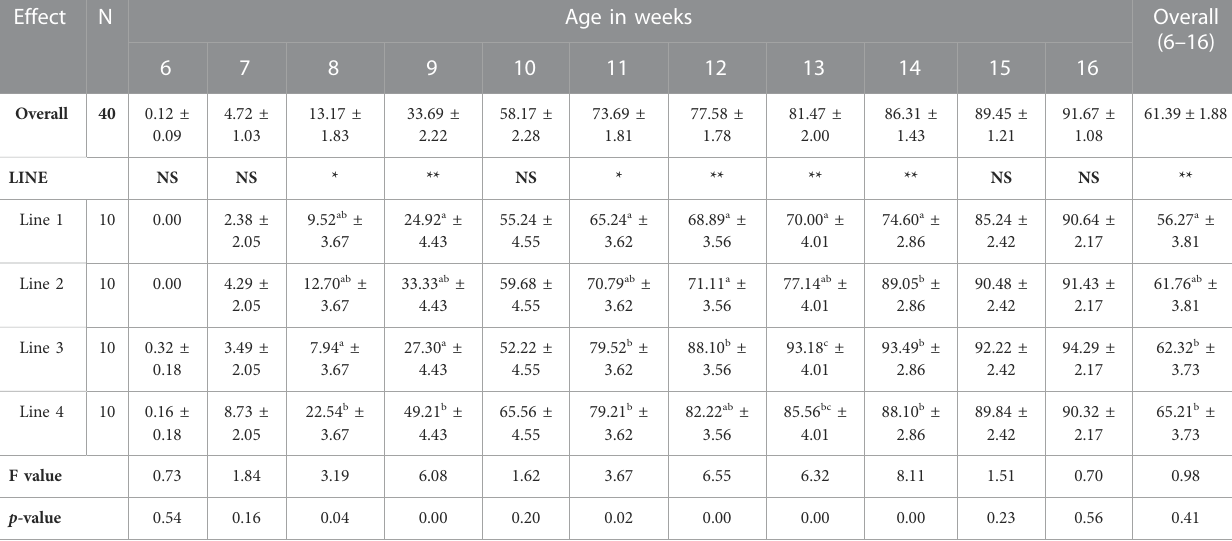
TABLE 6 Means (±S.E.) of hen-day egg production (%) of different lines of Japanese quail from 6th to 16th week of age. Effect